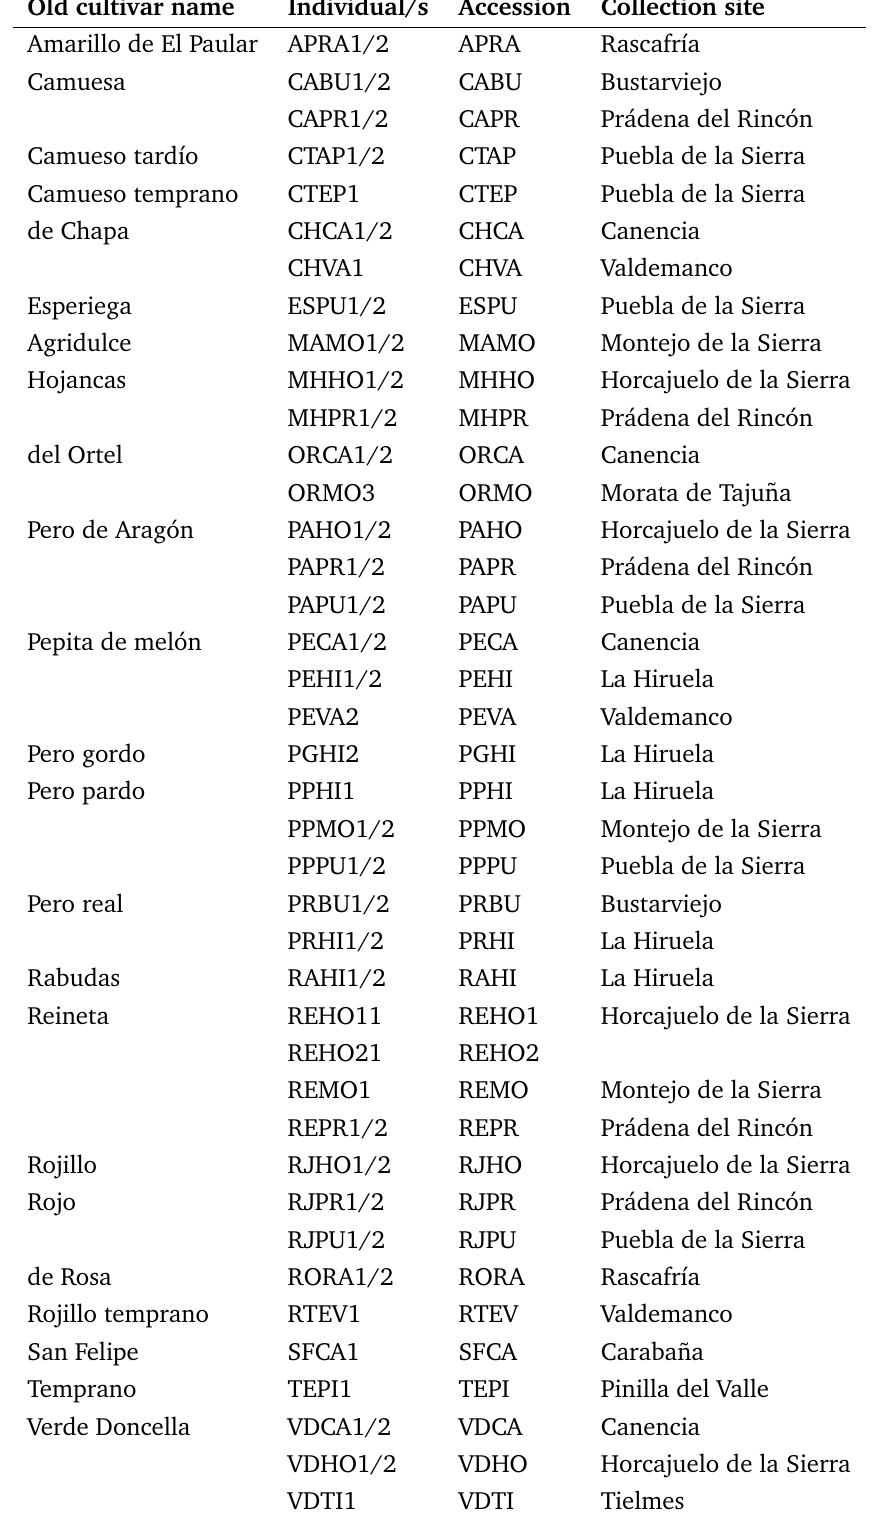
Table 1. Cultivar name, individual, accession andcollection site of the 23 old apple cultivars sampled in rural areas of central